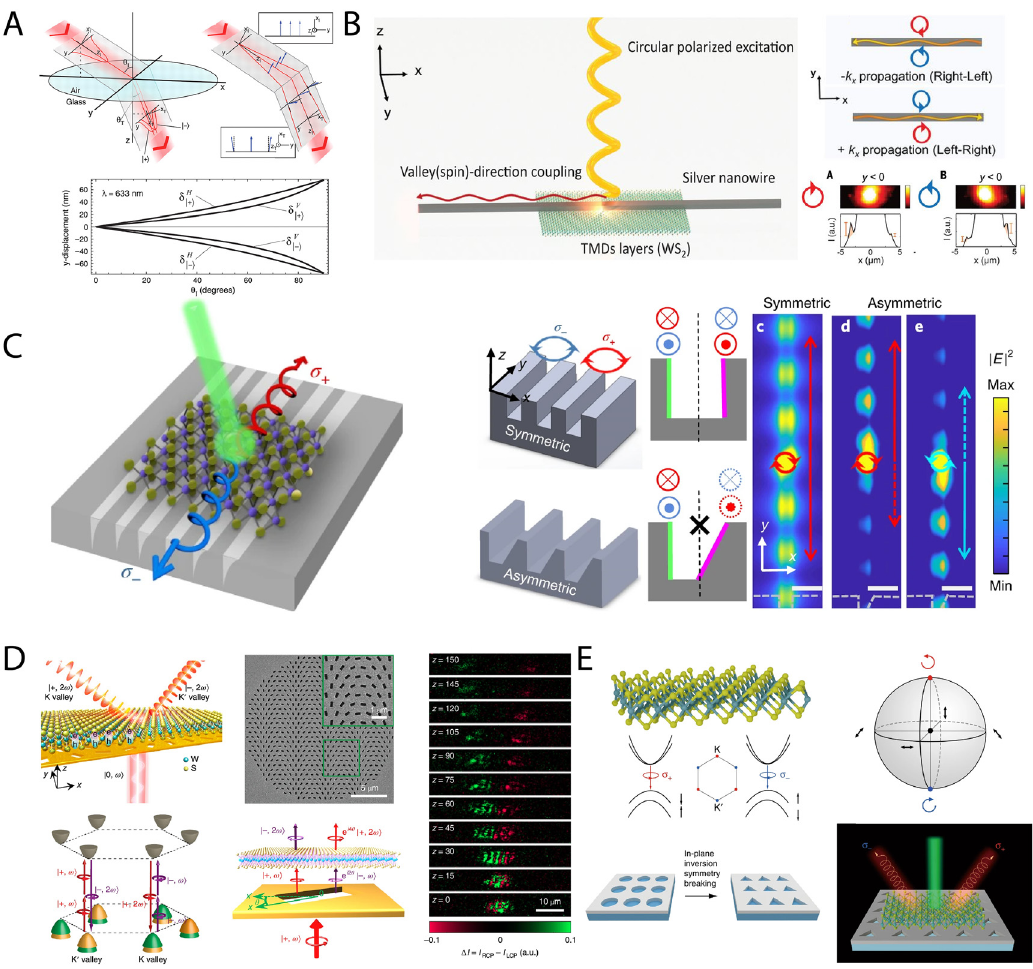
Figure 5: Metamaterials separate linearly polarized light into RCP and LCP light due to the optical spin Hall effect. (A) the schematic of the optical spin Hall effect (SHE) in the diffraction of an oblique incident light beam with an incident angle θ and right circular polarization from air to glass. Photons with σ + or σ − spin angular momentum acquired the momentum along y or − y direction at the interface of the two mediums, respectively [219]. (B) Linearly polarized incident light can be separated into RCP and LCP light by a silver nanowire(AgNW)(left).SPPsmodesinducedbytheAgNWpropagatetowardtwodirections: theseparatedRCPlightatrightsideandLCPlight at left side, respectively (top right). The WS 2 monolayer beneath the AgNW can be excited the K or K ′ valley-selective PL corresponding to the separatedRCPorLCPlight(lowerright)[12].(C)LinearlypolarizedincidentlightcanbeseparatedintoRCPandLCPlightduetotheopticalSHE. An asymmetric grating supports propagating SPPs modes at its cliffy sidewall rather than its oblique sidewall. The RCP and LCP light can be spatially separated toward divergent directions [126]. (D) A gold metamaterial can separate linearly polarized transmitted light into RCP and LCP light at the momentum-space. The K and K ′ valley selective PL of a monolayer WS 2 that is on the metamaterial would be excited and separated [223]. (E) An in-plane inversion symmetry breaking photonic crystal has manifested itself have the RCP and LCP light separation ability